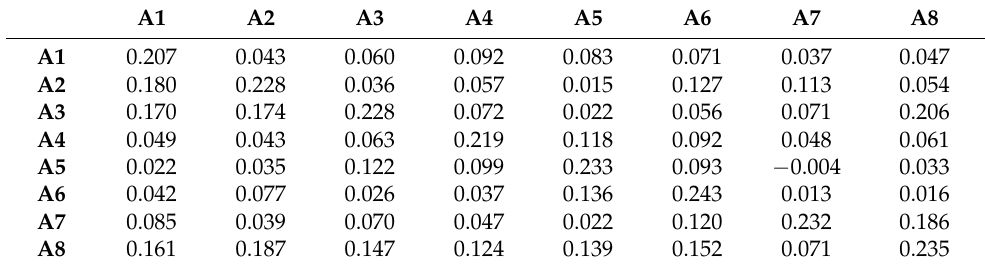
Table 5. Normalized direct relationship matrix of